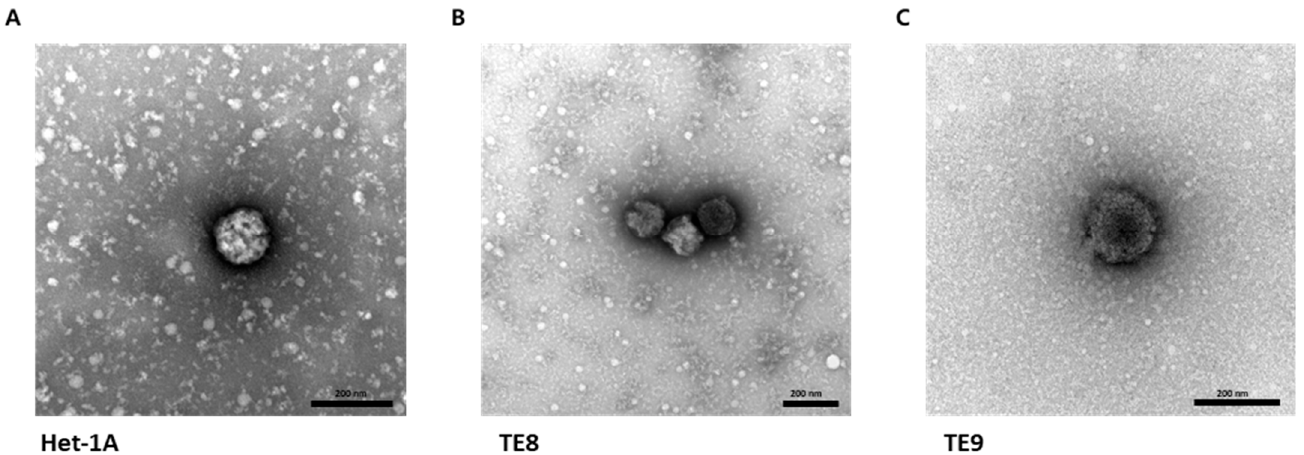
Figure 2. Images of esophageal cell line-derived exosomes. Representative transmission electron microscopic images of cellular exosomes isolated from Het-1A ( A ), TE8 ( B ), and TE9 ( C ) cell lines. Scale bar = 200 nm.